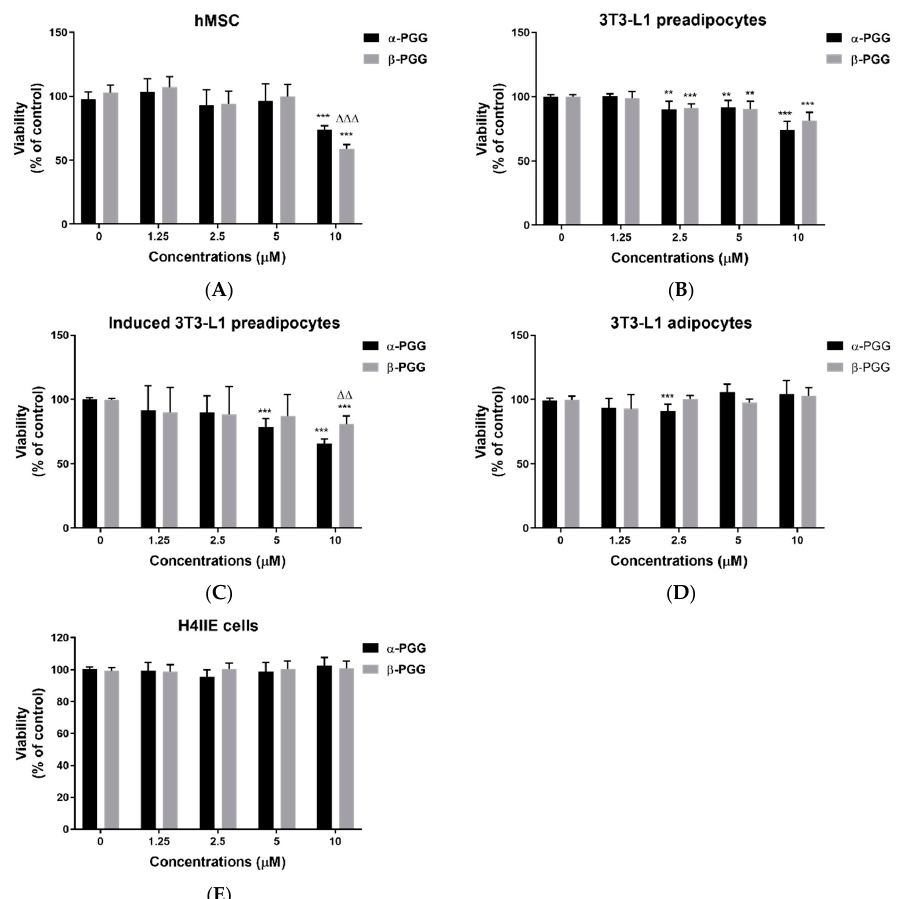
Figure 1. 1,2,3,4,6-Pentagalloylglucose (PGG) treatment reduced cell viability in various stages of the adipocyte lifecycle. Effects of α -or β -PGG on cell viability of ( A ) human mesenchymal stem cells (hMSCs; n = 5), ( B ) 3T3-L1 fibroblasts/pre-adipocyte ( n = 5), ( C ) differentiating 3T3-L1 cells ( n = 14), ( D ) differentiated 3T3-L1 adipocytes ( n = 9), and ( E ) rat hepatoma H4IIE cells ( n = 5). Data are shown as mean ± SEM. ** p < 0.01 and *** p < 0.001 compared to control (vehicle). ∆∆ p < 0.01 and ∆∆∆ p < 0.001 compared with corresponding α -PGG group.